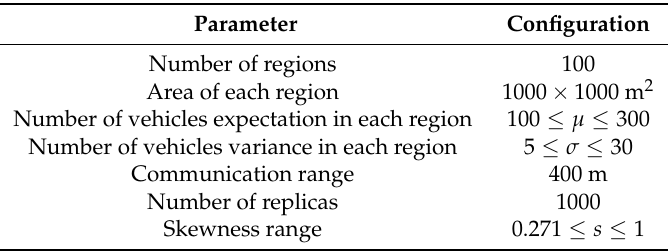
Figure 8. Skewness with different parameter s . Table 1. Region-level parameter